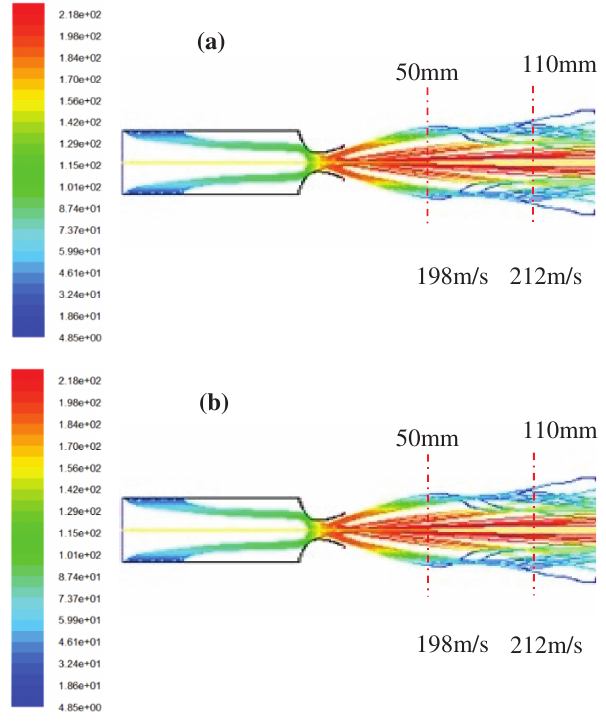
Figure 10: 10 um particle distribution of velocity at different Mach number: (a) Mach 0.3 and (b) Mach 0.5.